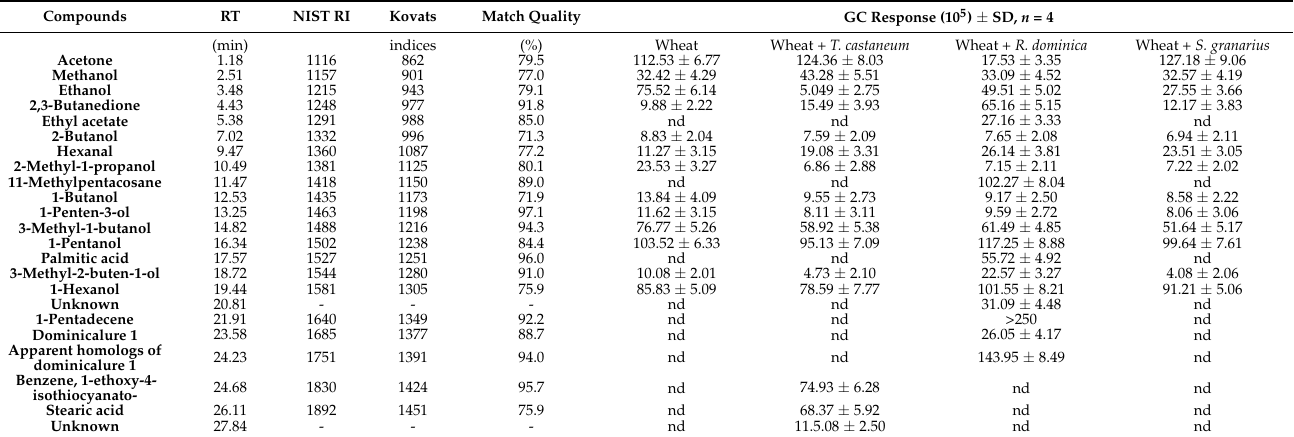
Table 2. Volatile organic compounds (VOCs) collected from wheat only, wheat plus T. castaneum , wheat plus R. dominica , and wheat plus S. granarius identified from gas chromatography analysis and Kovats’ values